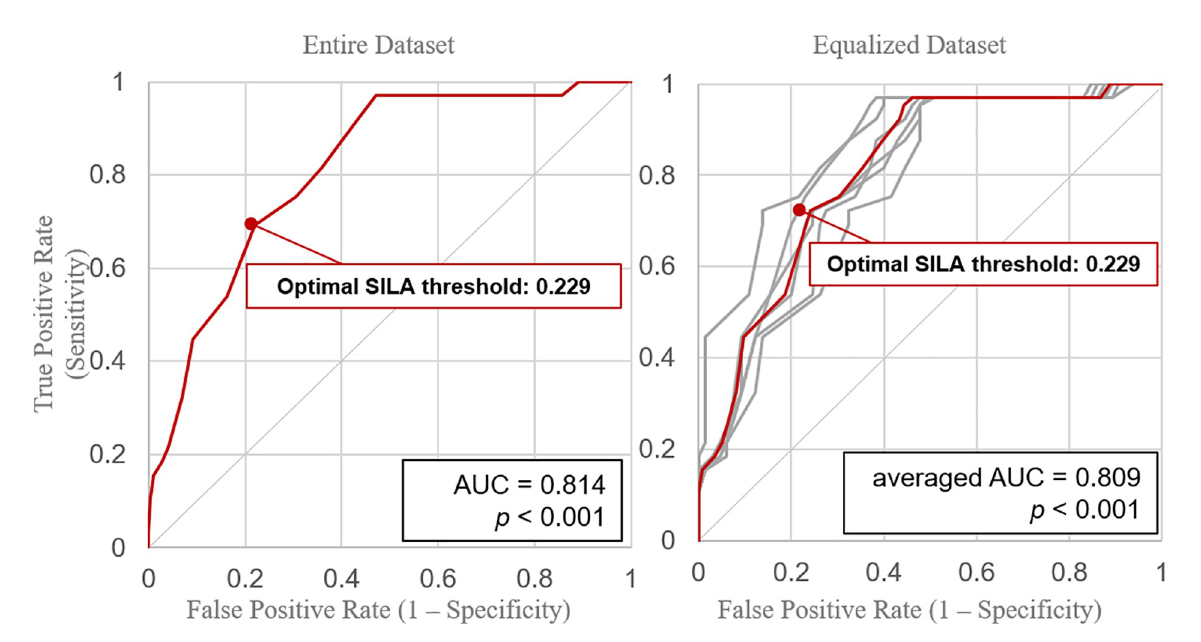
Fig 3. The Receiver Operating Characteristic (ROC) curves of distinguishing indolent and invasive nodules. (A) ROC curve by following Score Indicative of Lung Cancer Aggression (SILA) as thresholds by using the entire dataset. (B) ROC curves of six arbitrarily selected datasets and the macro- averaged curve for evenly distribution of indolent and invasive nodules.